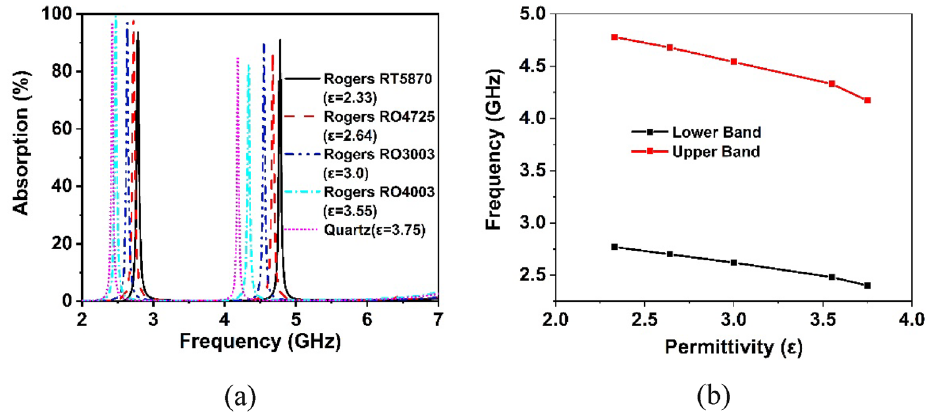
Figure 25. ( a ) Absorption responses of various sensing materials and ( b ) Plot of dielectric constant against frequency at the point of maximum absorption.